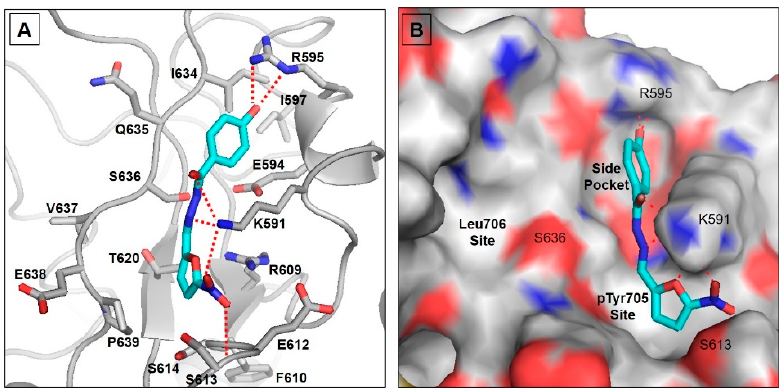
Figure 1. Molecular docking for nifuroxazide. ( A ) Proposed binding model of nifuroxazide in the binding cleft of STAT3. The ligand is displayed as cyan sticks, and the important protein residues are displayed as gray sticks with a cartoon backbone. ( B ) Surface representation of the STAT3 binding cleft showing the three binding pockets discussed.